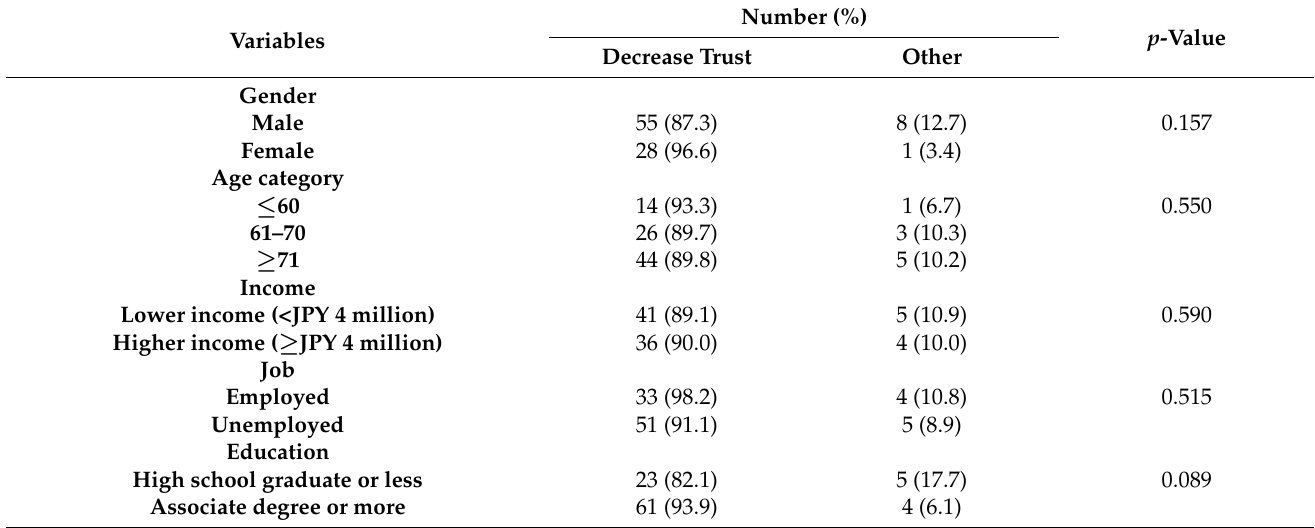
Table 4. Number and percent of respondents reporting decreased trust in at least one physician– Pharma interaction by respondent